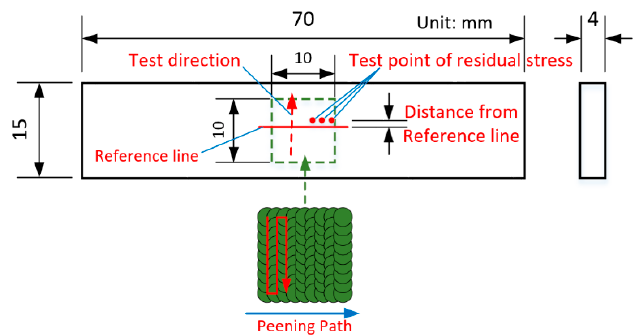
Figure 1. Shape and size diagram of rectangular samples and test solutions of residual stress.